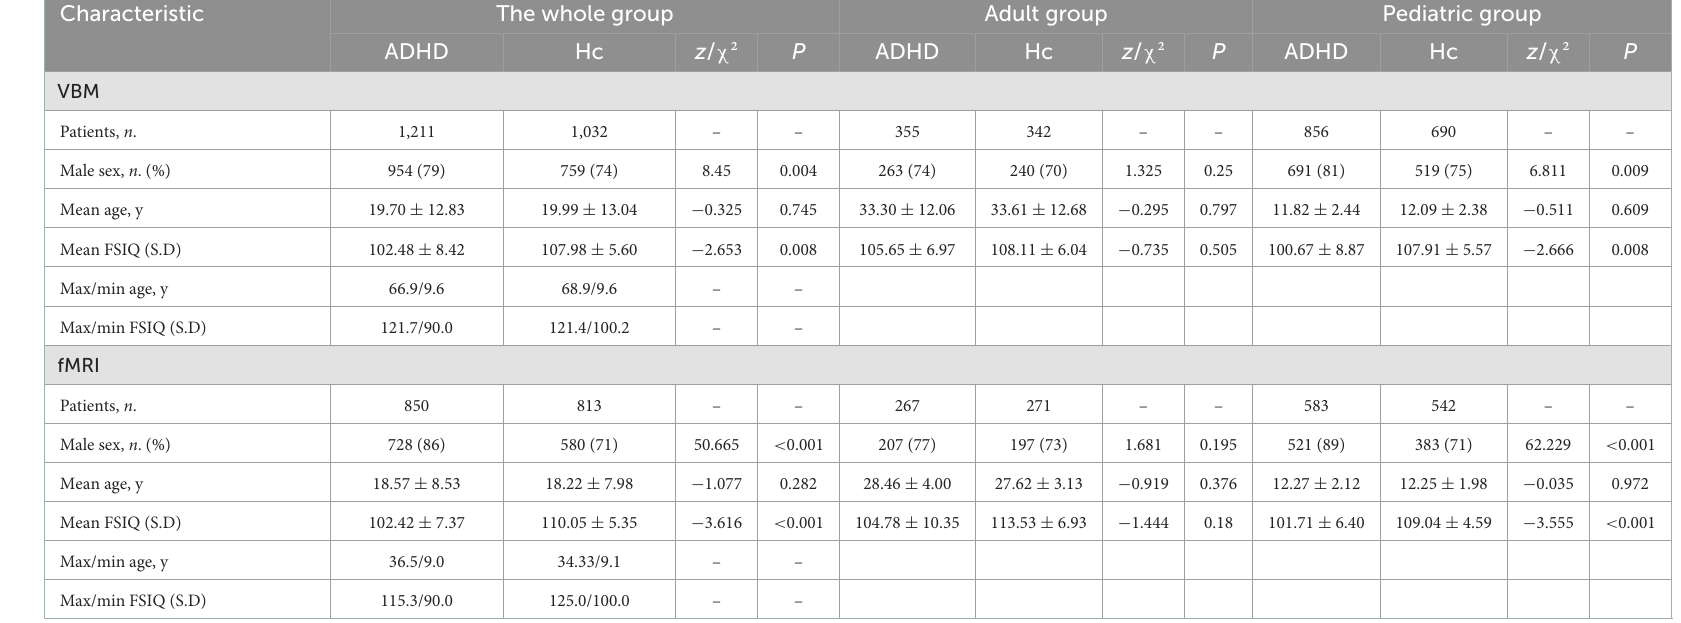
TABLE 2 Demographic information for studies included in the meta-analysis. Characteristic The whole